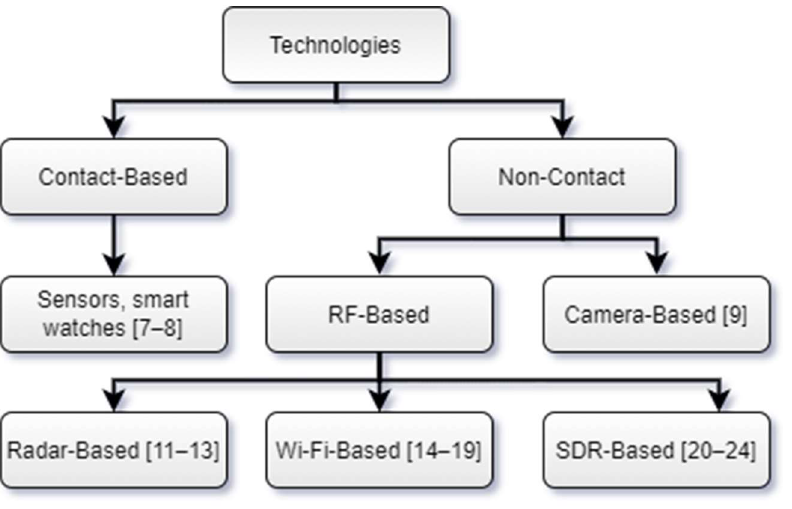
Figure 2. Literature review summary.